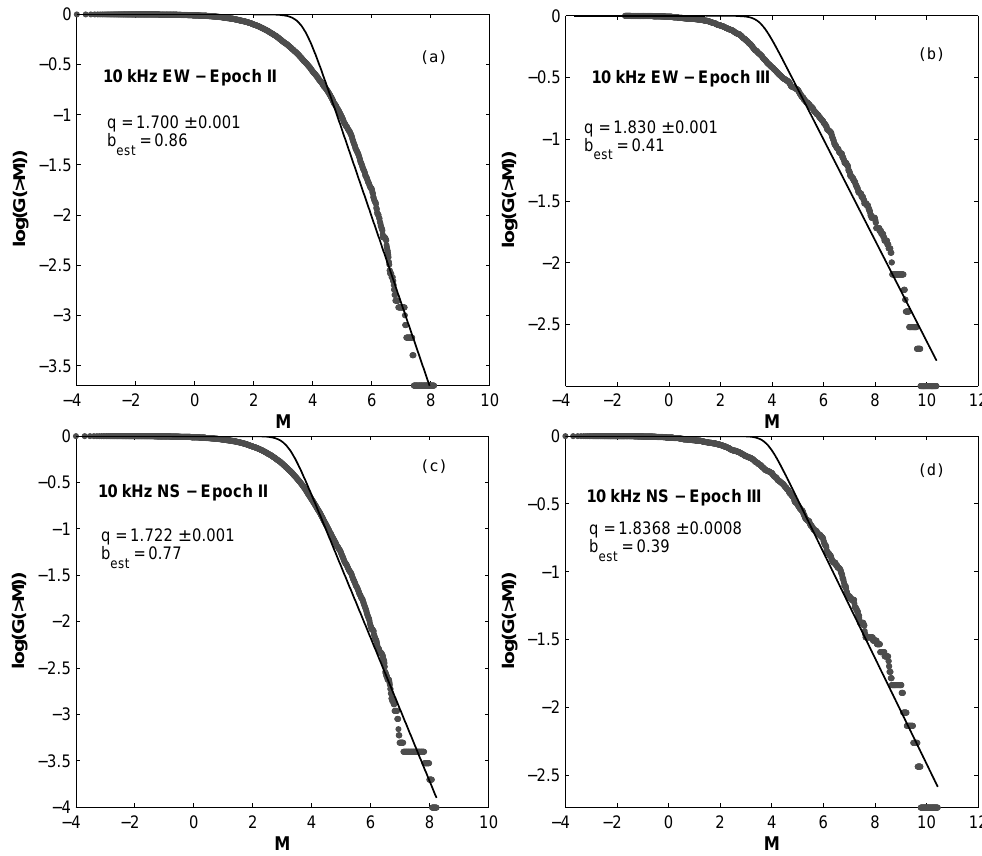
Fig. 10. Equation (8) is used to calculate the relative cumulative number of “electromagnetic earthquakes” (see text), G(> M) , included in the epochs II and III defined in Fig. 2, for the EM time-series recorded by the 10kHz EW ( a and b ), and 10kHz NS detectors ( c and d ). A excellent fit of Eq. (8) to the data is observed. The grey dots correspond to the experimental data, while the black curve is the fitting obtained.